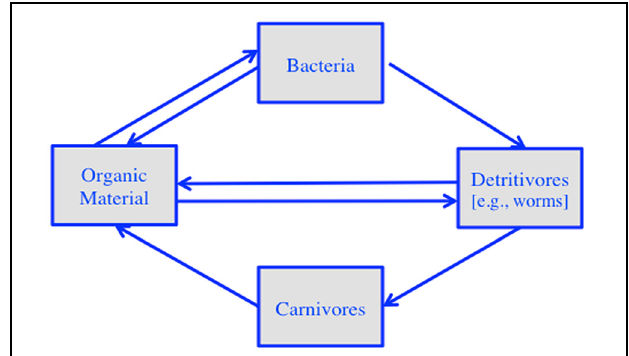
FIGURE 1 | Schema of an idealized ecosystem exchanging energy in a self-sustaining